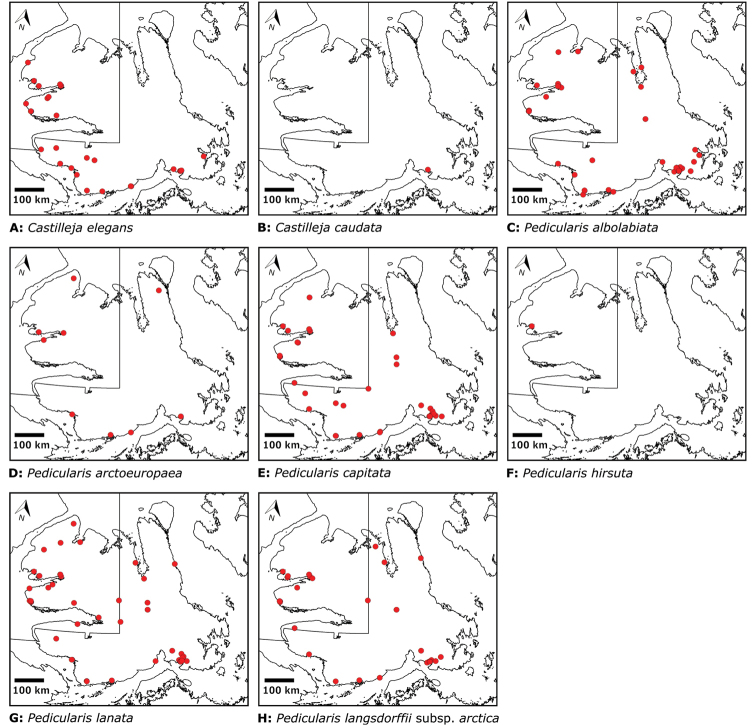
Species distribution maps. Orobanchaceae: ACastilleja
elegansBCastilleja
caudataCPedicularis
albolabiataDPedicularis
arctoeuropaeaEPedicularis
capitataFPedicularis
hirsutaGPedicularis
lanataHPedicularis
langsdorffii
subsp.
arctica.